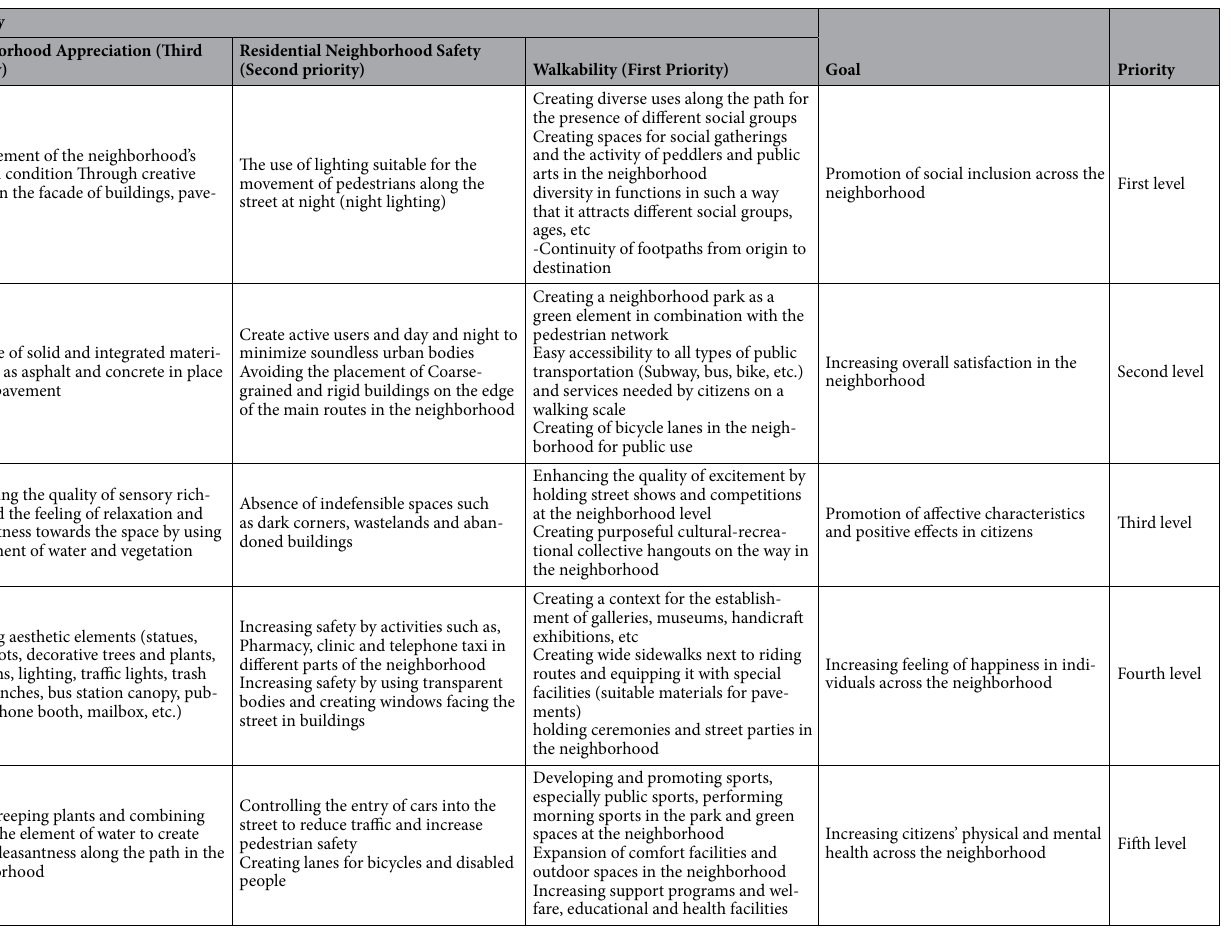
Table 9. Goals and strategies for promoting citizens’ subjective well-being in neighborhood as an artificial